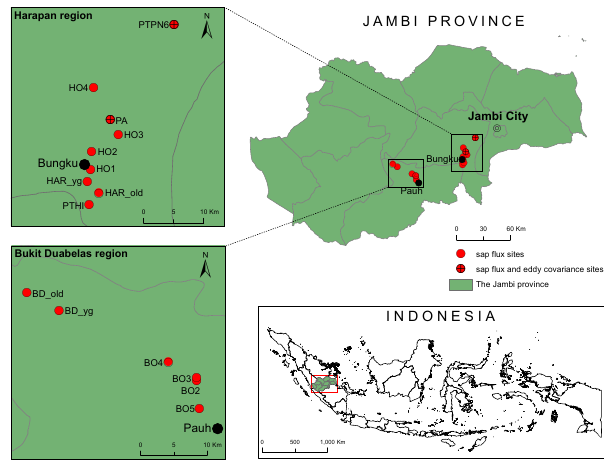
Figure 1. Locations of the studied oil palm stands in Jambi province, Sumatra,